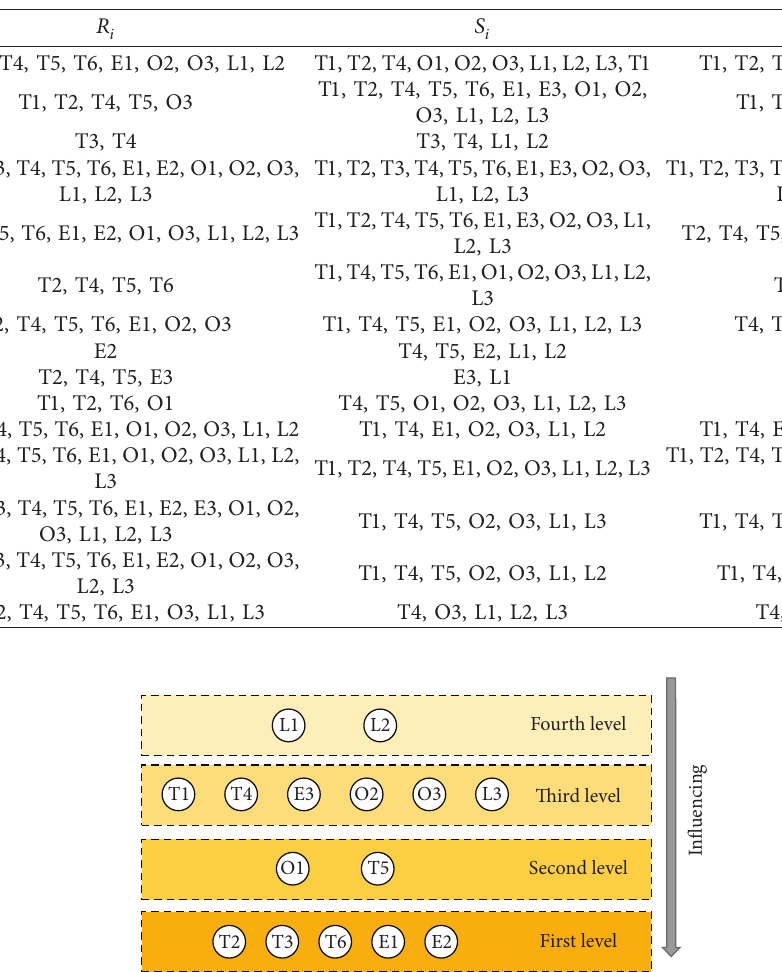
Table 13: Reachable, antecedent sets, and their joint set.